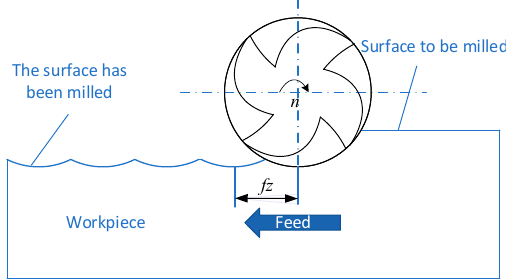
Figure 4. Milling machining ideal surface.